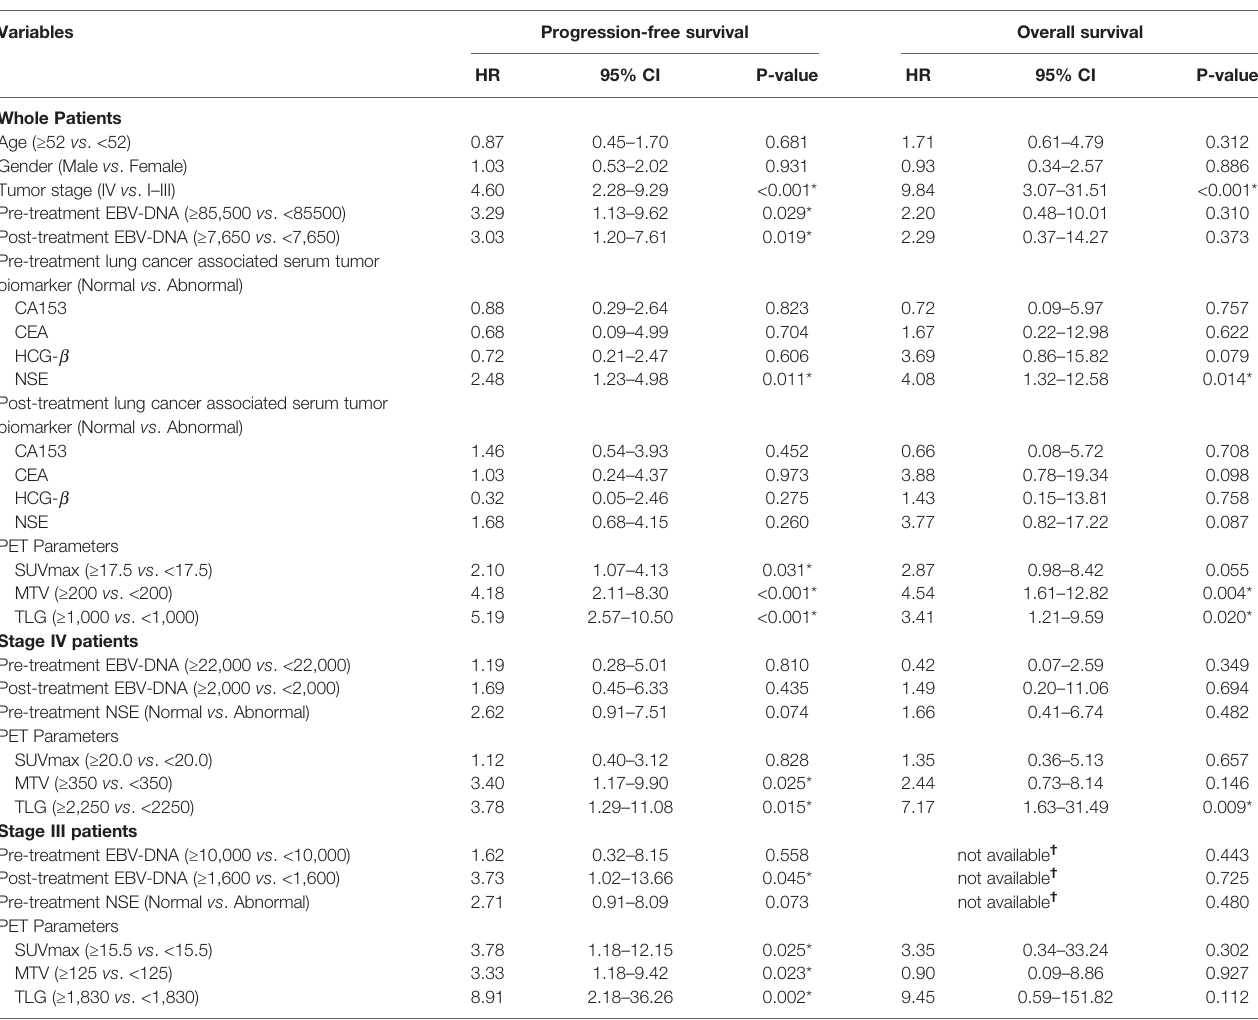
TABLE 3 | Univariate analysis for PFS and OS in patients with pulmonary LELC. Variables Progression-free survival Overall